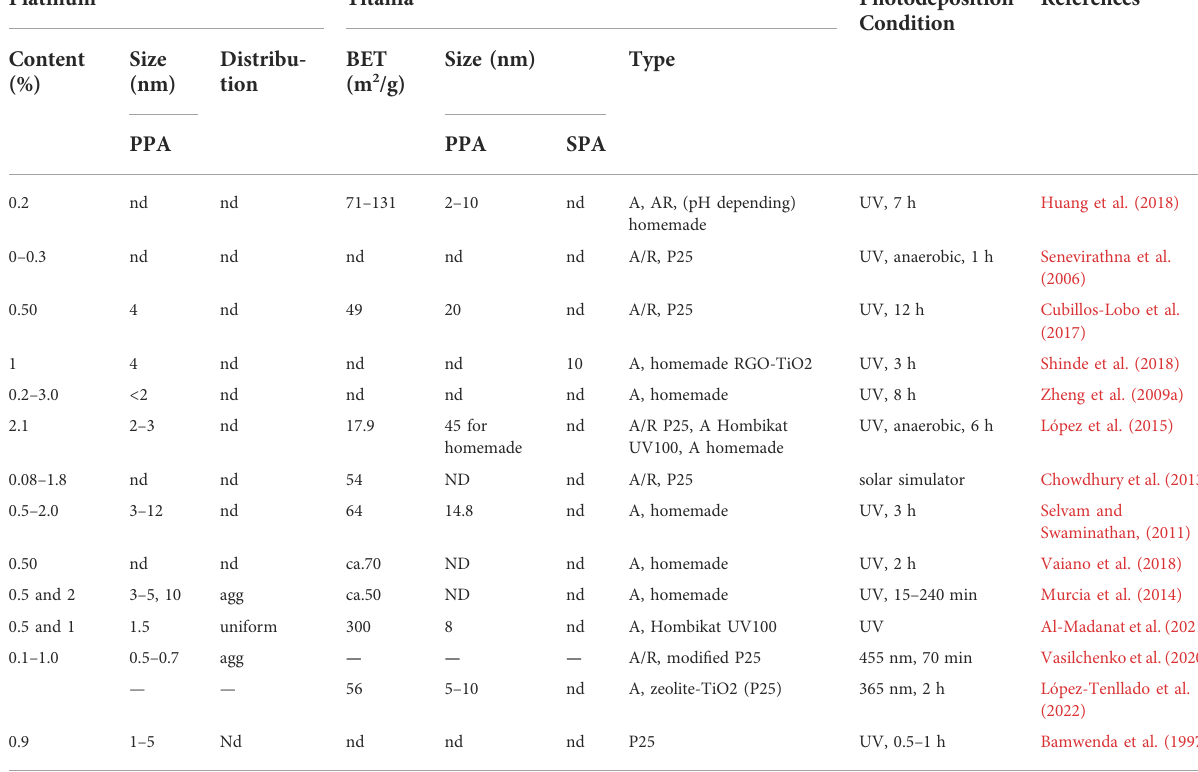
TABLE 1 The examples of Pt/TiO 2 photocatalysts ’ preparation by photodeposition method. Platinum